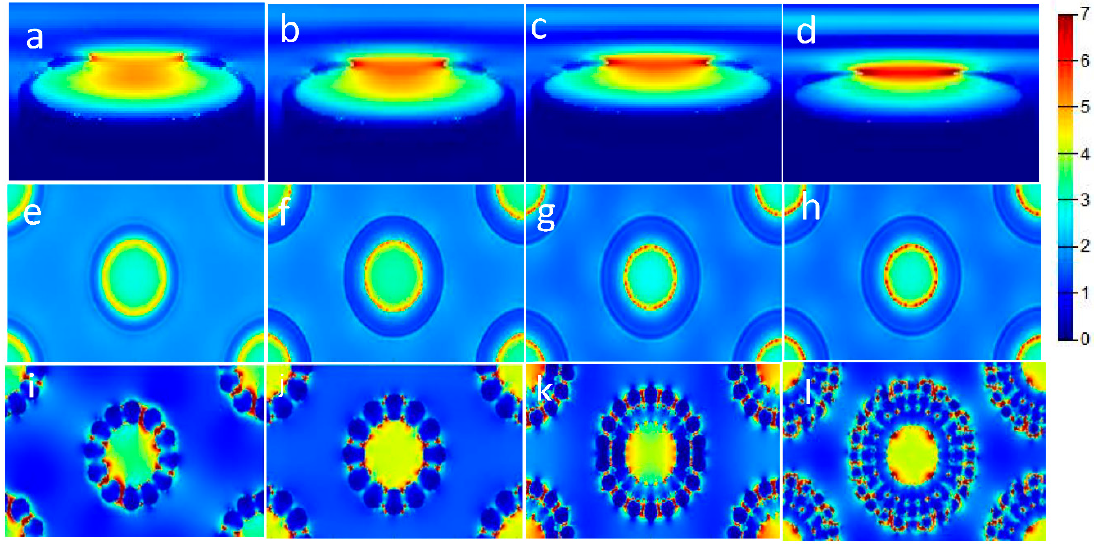
Figure 5. Nanojar structure tilted at 70° with sputtering times given by: ( a ) 15 s, ( b ) 30 s, ( c ) 45 s, ( d ) electric field image of 60 s structure. ( a – d ) Electric field image of the y–z plane at 0 nm, ( e – h ) is an electric field image of the x–z plane at 760 nm. ( i – l ) is the electric field plane after the ( e – h ) reaction. Circularly polarized light was applied for all sources.